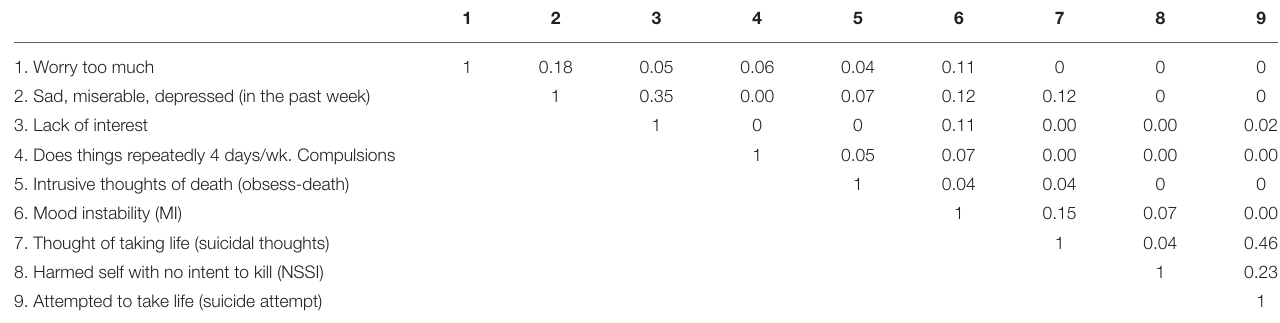
TABLE 3 | Partial correlations of mood symptoms.